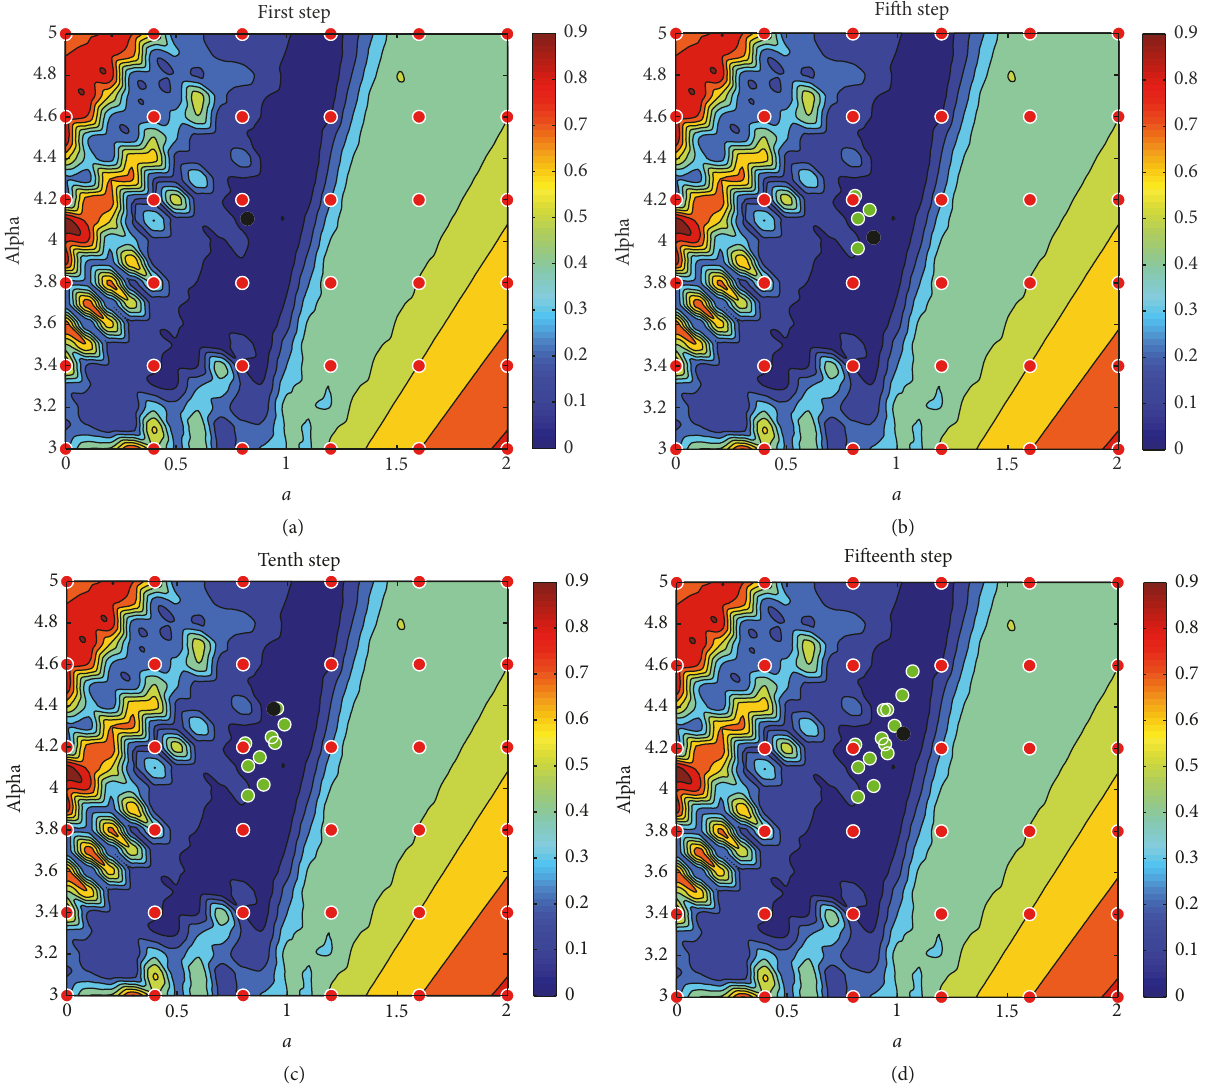
Figure 4: Process of finding the best parameters using MTMED algorithm. (a), (b), (c), and (d) represent the first, 5th, 10th, and 15th iteration, respectively. It can be seen that the individuals (points) converge to the optimum area. Red, green, and black points show the first, newly generated, and queen data in every